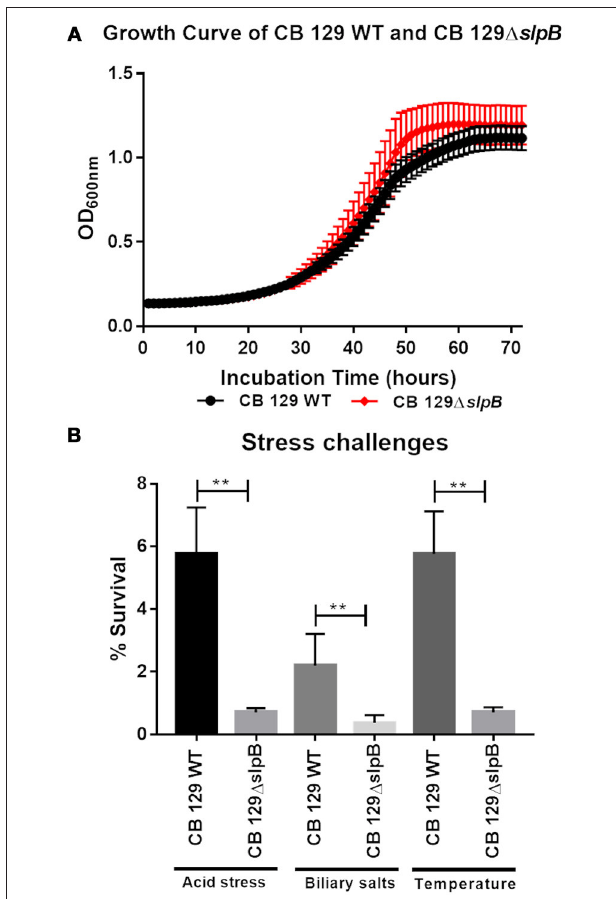
FIGURE 3 | Mutation of Slp B drastically affects stress tolerance in P. freudenreichii CIRM-BIA 129. (A) The growth curve of Wild-type (WT) and mutant CB129 1 slpB strains was determined at 30 ◦ C in YEL broth until stationary phase (72h). Growth was monitored by OD 650nm as a function of time. No statistically significant difference was found in growth curve between strains. (B) Wild-type (WT) and mutant 129 1 slpB strains were subjected to acid, bile salts and thermal challenges. Viable propionibacteria were enumerated by plate counting before and after each challenge. Asterix represent statistically significant differences between strains and were indicated as follows: ** p <